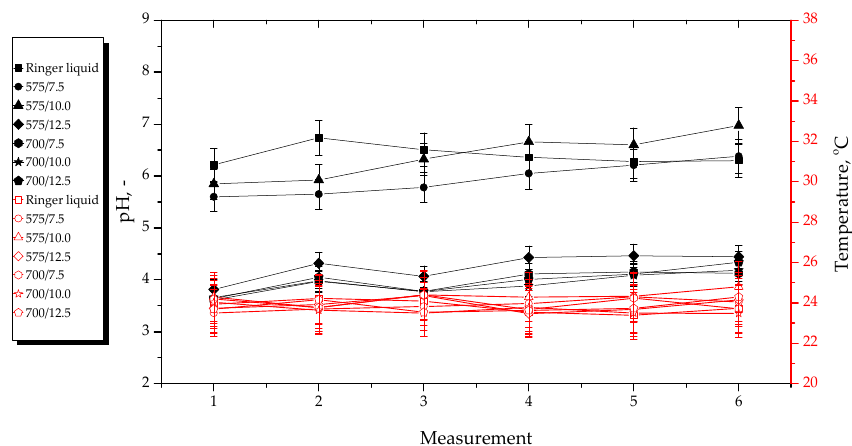
Figure 12. pH and temperature measurements during incubation of hydrogels in SBF.